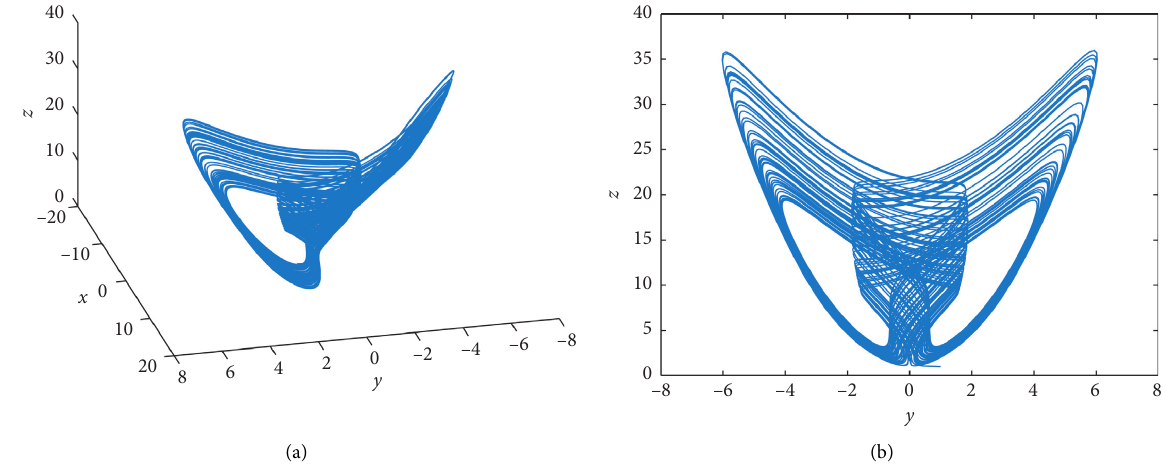
Figure 13: Phase portraits of the fractional system with b � 9 . 5 and α � 0 .